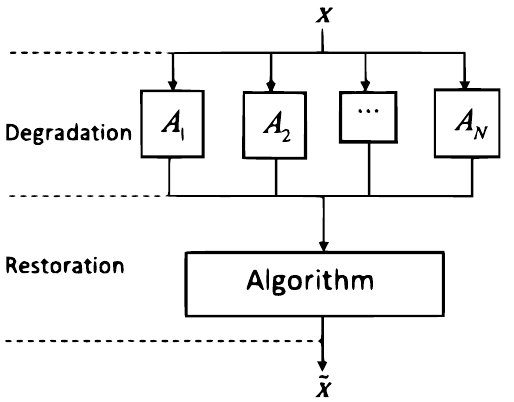
Figure 7. The flowchart of the image restoration